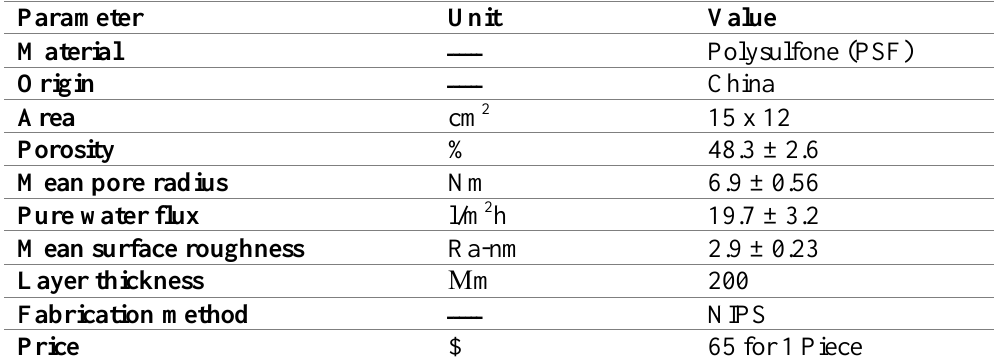
Table 2: Specifications of PSF commercial membrane